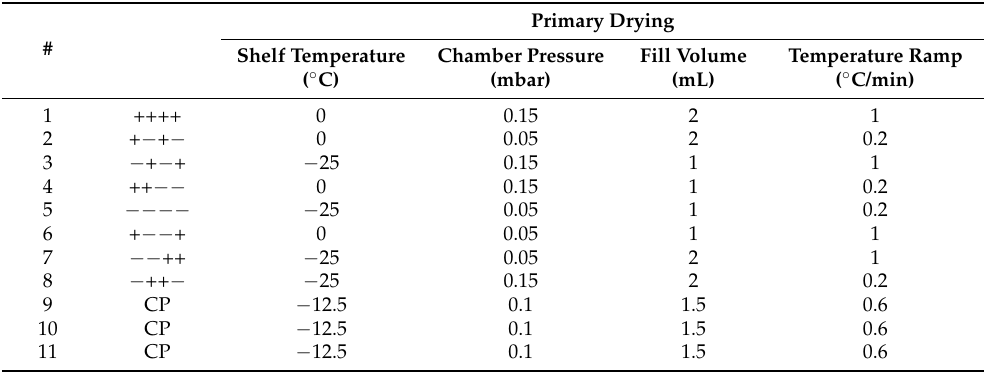
Table 1. Experimental Design of Experiments